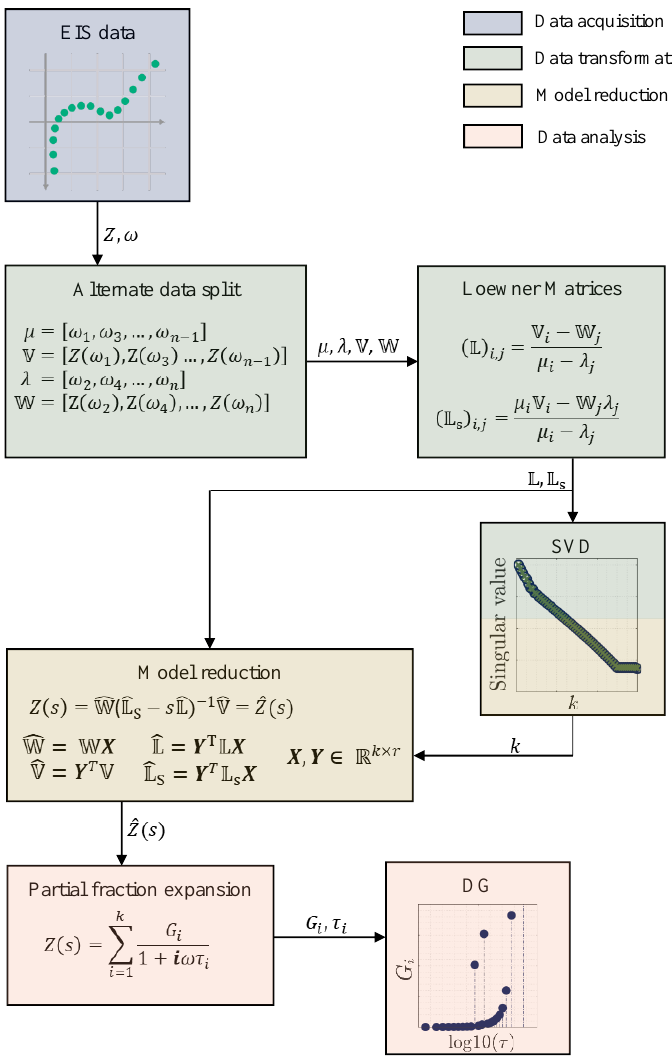
Figure 1. Flow chart of the